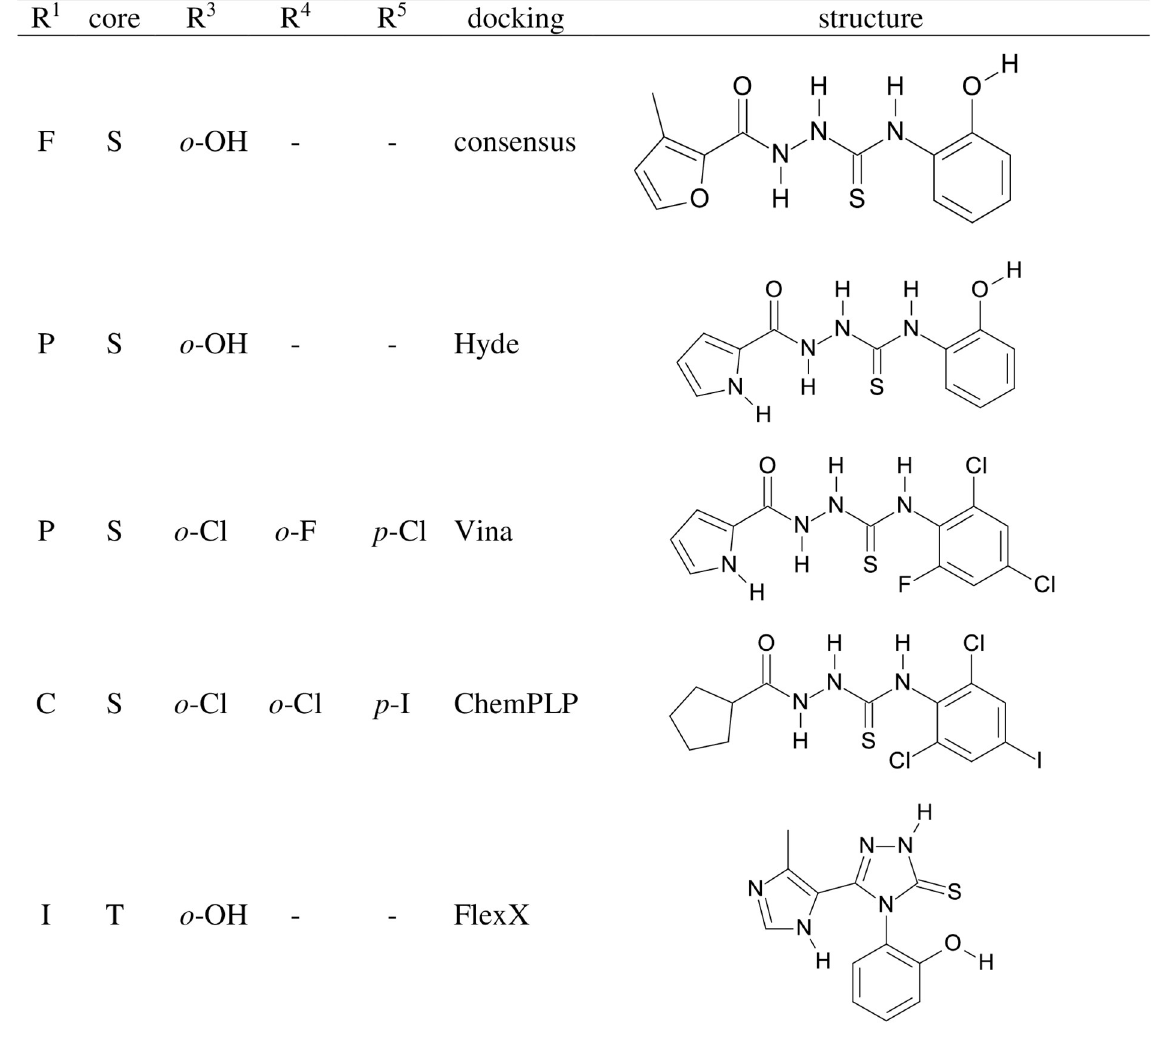
Fig 5. Structure of the molecules with the best scores for individual docking and consensus